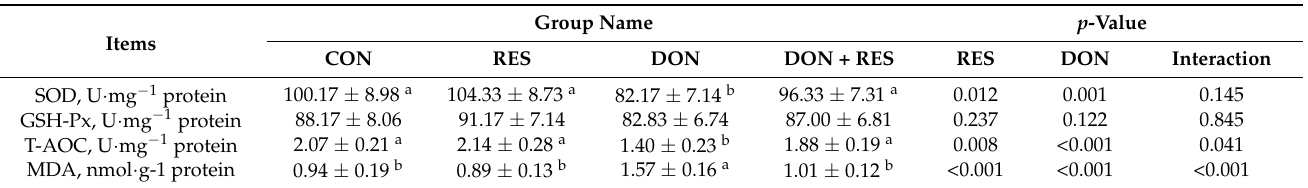
Table 7. The effects of RES on antioxidant enzymes activities and MDA content in the jejunum of